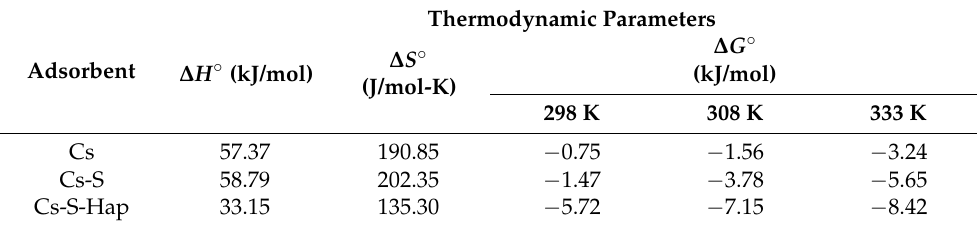
Table 4. Thermodynamic parameters for Cr(VI)